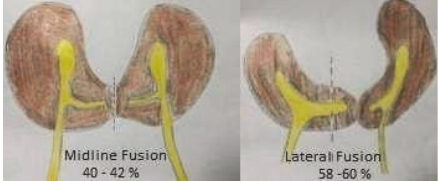
Figure 5: Midline lower polar fusion (40 to 42%) and lateral lower polar fusion (58% to